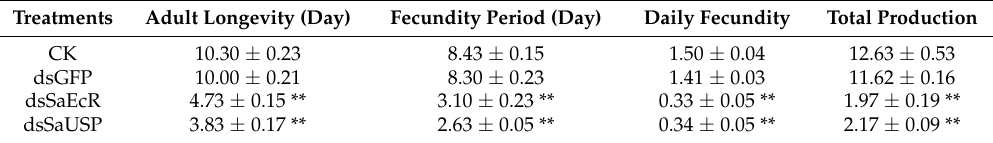
Table 1. The fitness parameters of grain aphids on wheat plants after dsRNA feeding.